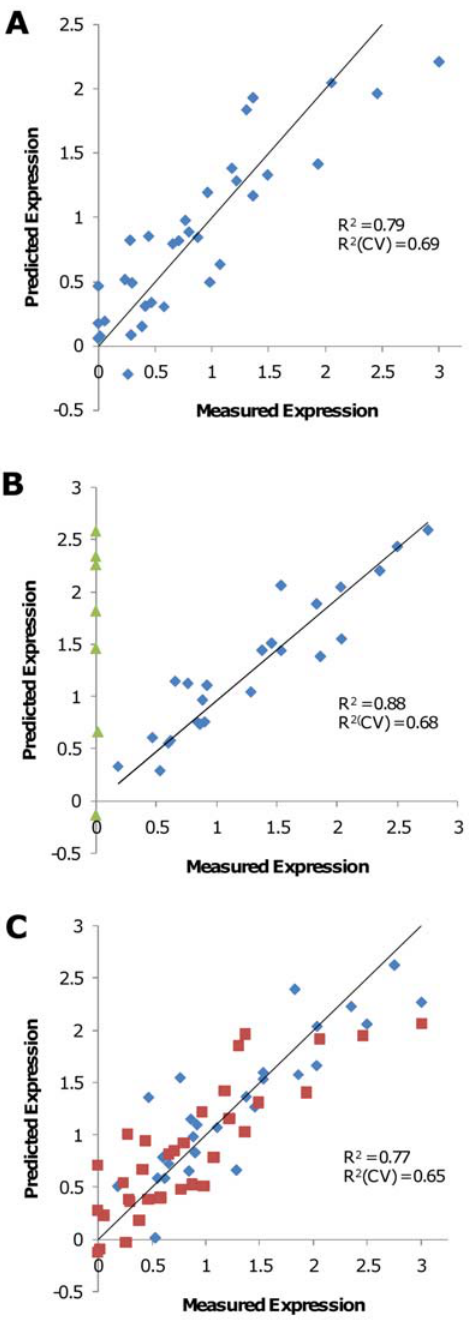
Figure 2. PLS codon frequency models. For each variant the measured expression level was plotted against the expression predicted from a PLS model using genetic algorithm-selected codons. (A) Model fit for polymerase variant expression data. Blue diamonds indicate the 34 gene training set used to create the model. (B) Model fit for scFv expression data. Blue diamonds indicate the 24 gene training set used to create the model. Green triangles are variants from the initial set with undetectable expression, and which were not used for model building. (C) Combined model constructed from polymerase variants (34 red squares) and scFv variants (27 blue diamonds). Expression in each set was normalized to the highest expression level in that set (=3). R 2 (CV) indicates the correlation coefficient for the fit of the model in cross- validation (see Materials and Methods). Variants used to provide datapoints for construction of the models are indicated in Table